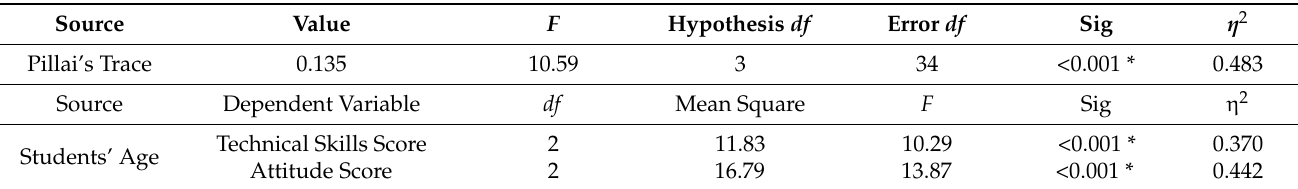
Table 3. Multivariate test of knowledge, technical skills, and attitude towards CPR among students following the